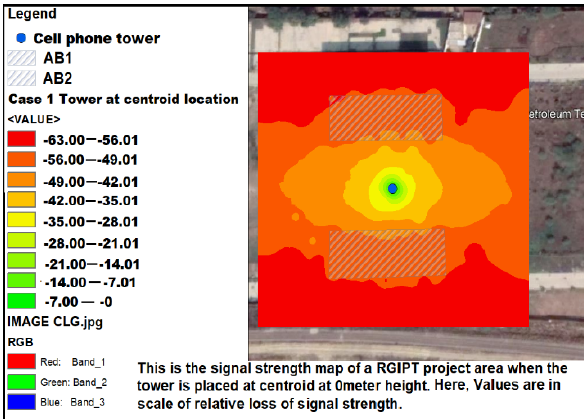
Figure 13. Cell phone tower at XY centroid